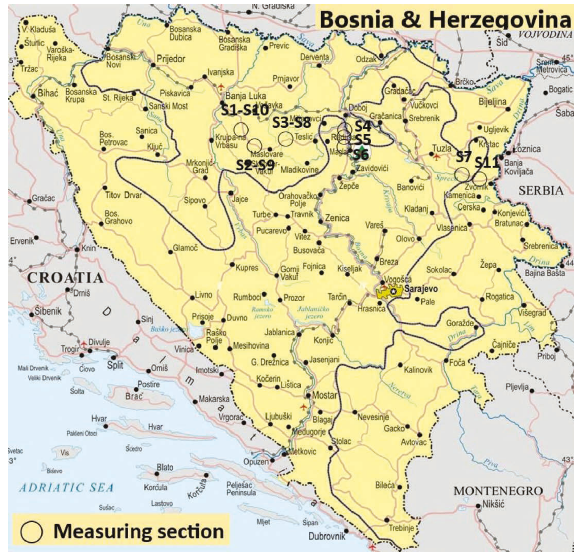
Figure 1: Position of measuring sections (S